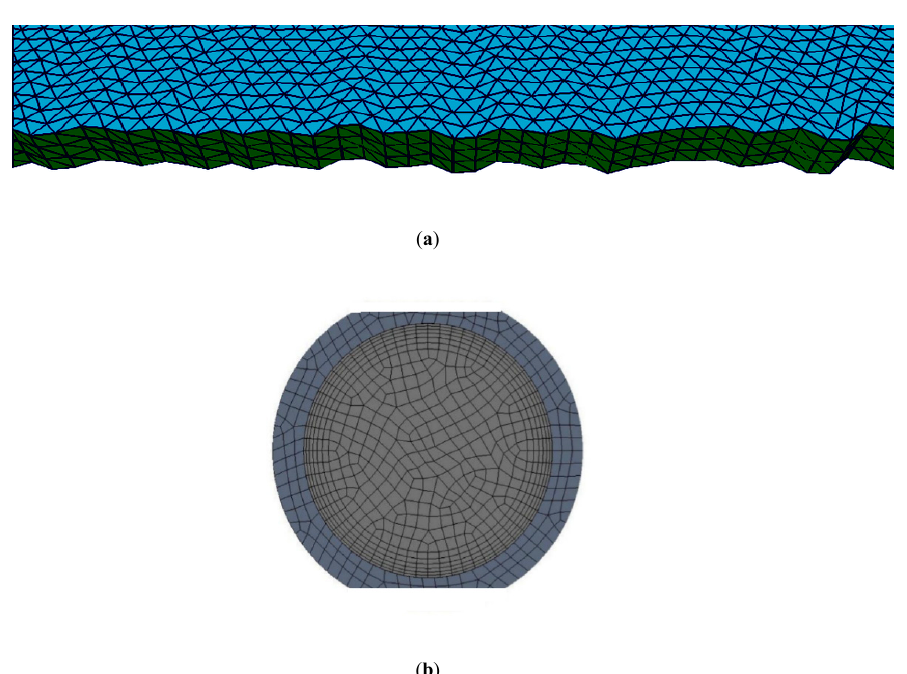
Figure 5. ( a ) Mesh along the thickness of panel. ( b ) Mesh inside and outside the tube. Table 5. Grid independence test